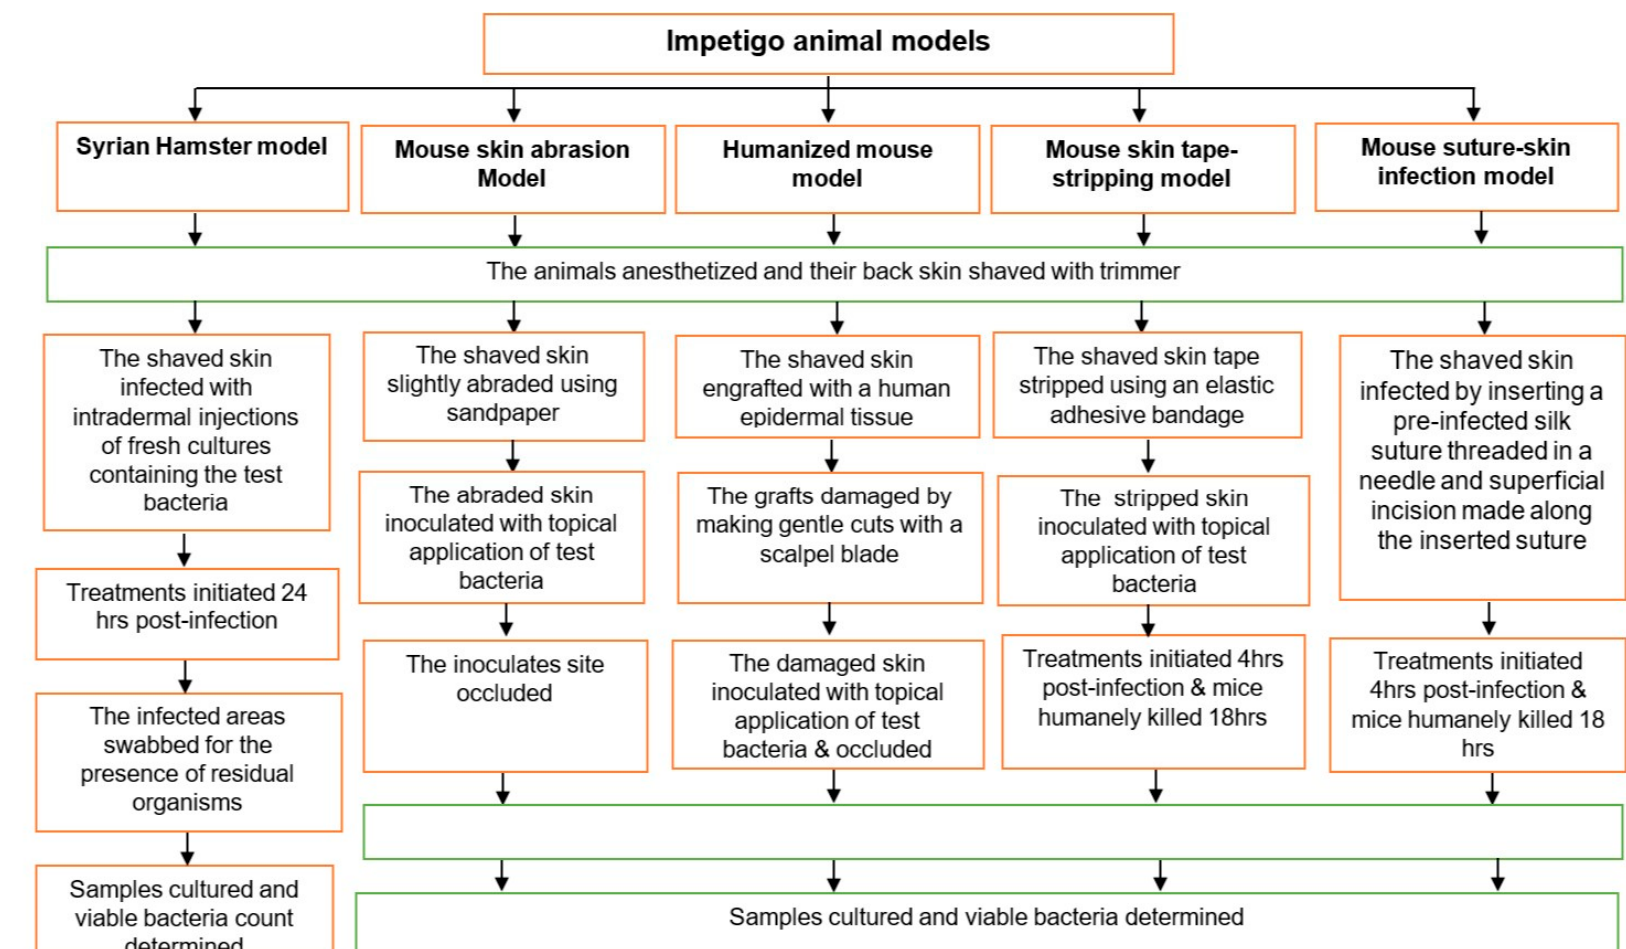
Figure 1. Summary flow diagram of the rodent models investigated for impetigo.